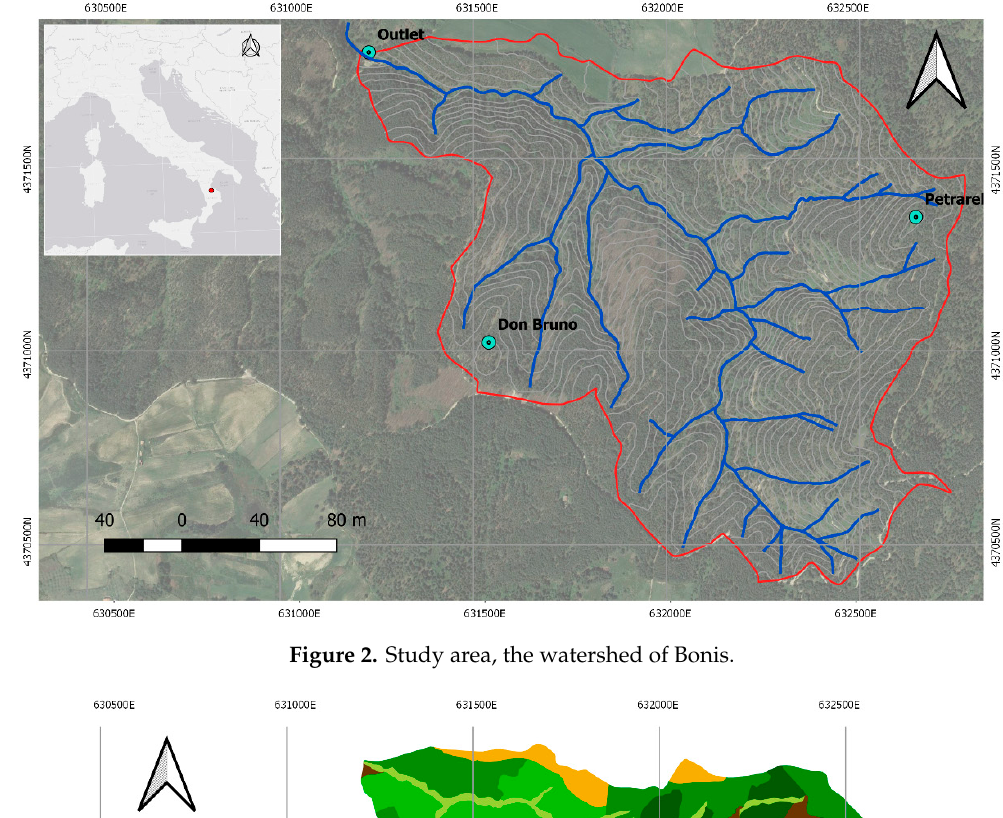
Figure 2. Study area, the watershed of Bonis.